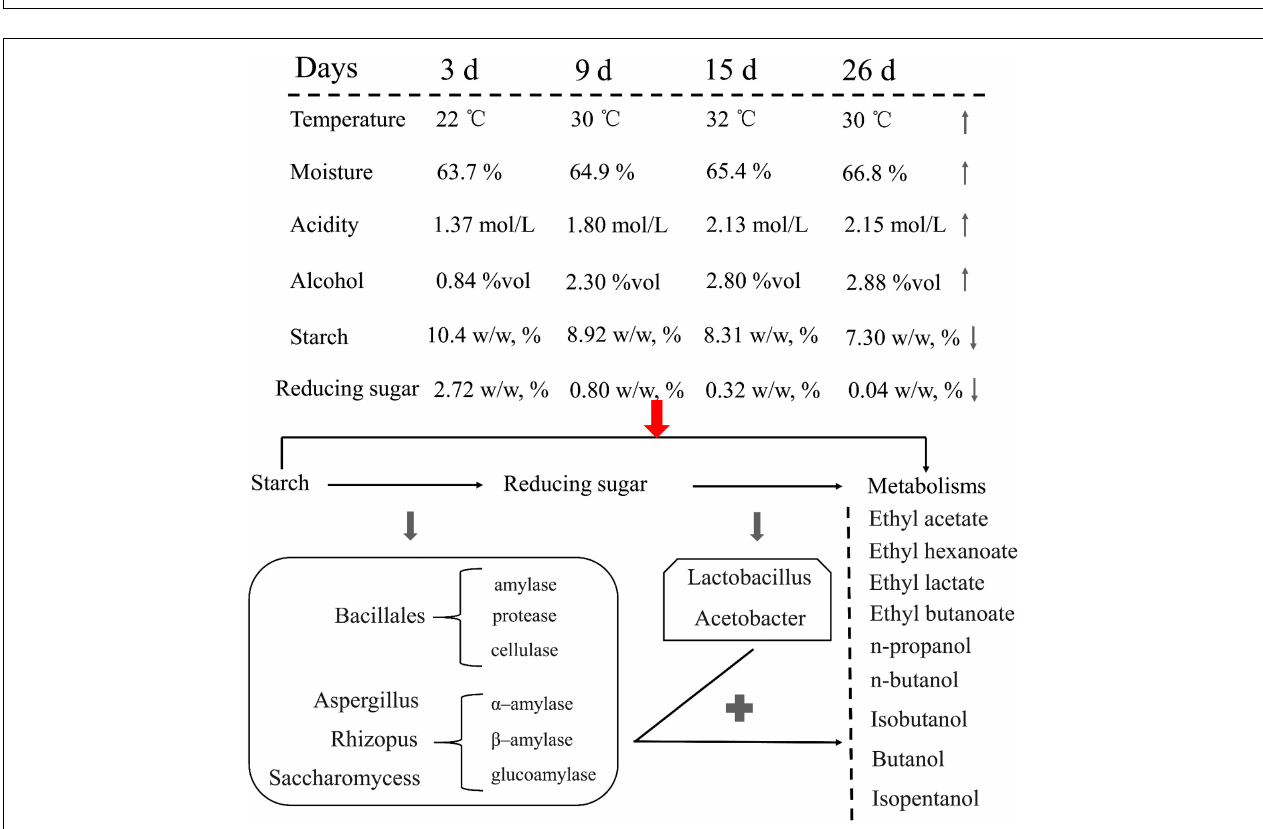
FIGURE 6 | Co-occurrence network of bacterial and fungal communities (phyla, class, order, and genus) of fermented grains and volatile compounds of liquor based on correlation analysis. A connection stands for a strong positive [ (A) , Spearman’s ρ > 0.6] or negative [ (B) , Spearman’s ρ > –0.6] correlation. The thickness of the line is proportional to the absolute value of Spearman’s correlation